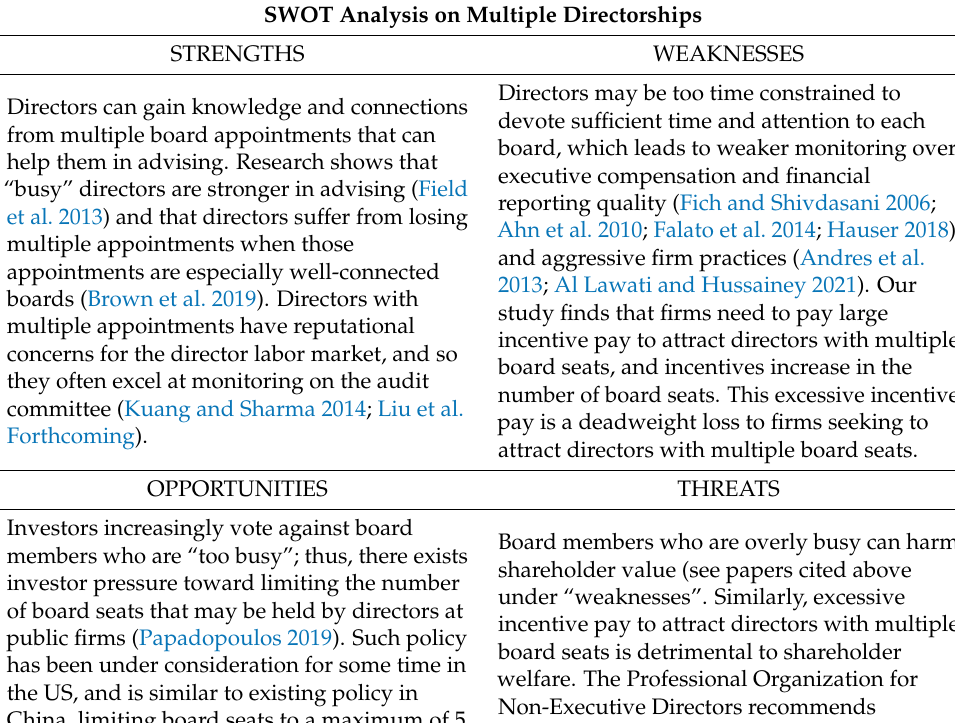
Table 1. SWOT analysis (strengths, weaknesses, opportunities, threats) of the effects of multiple directorships on firm